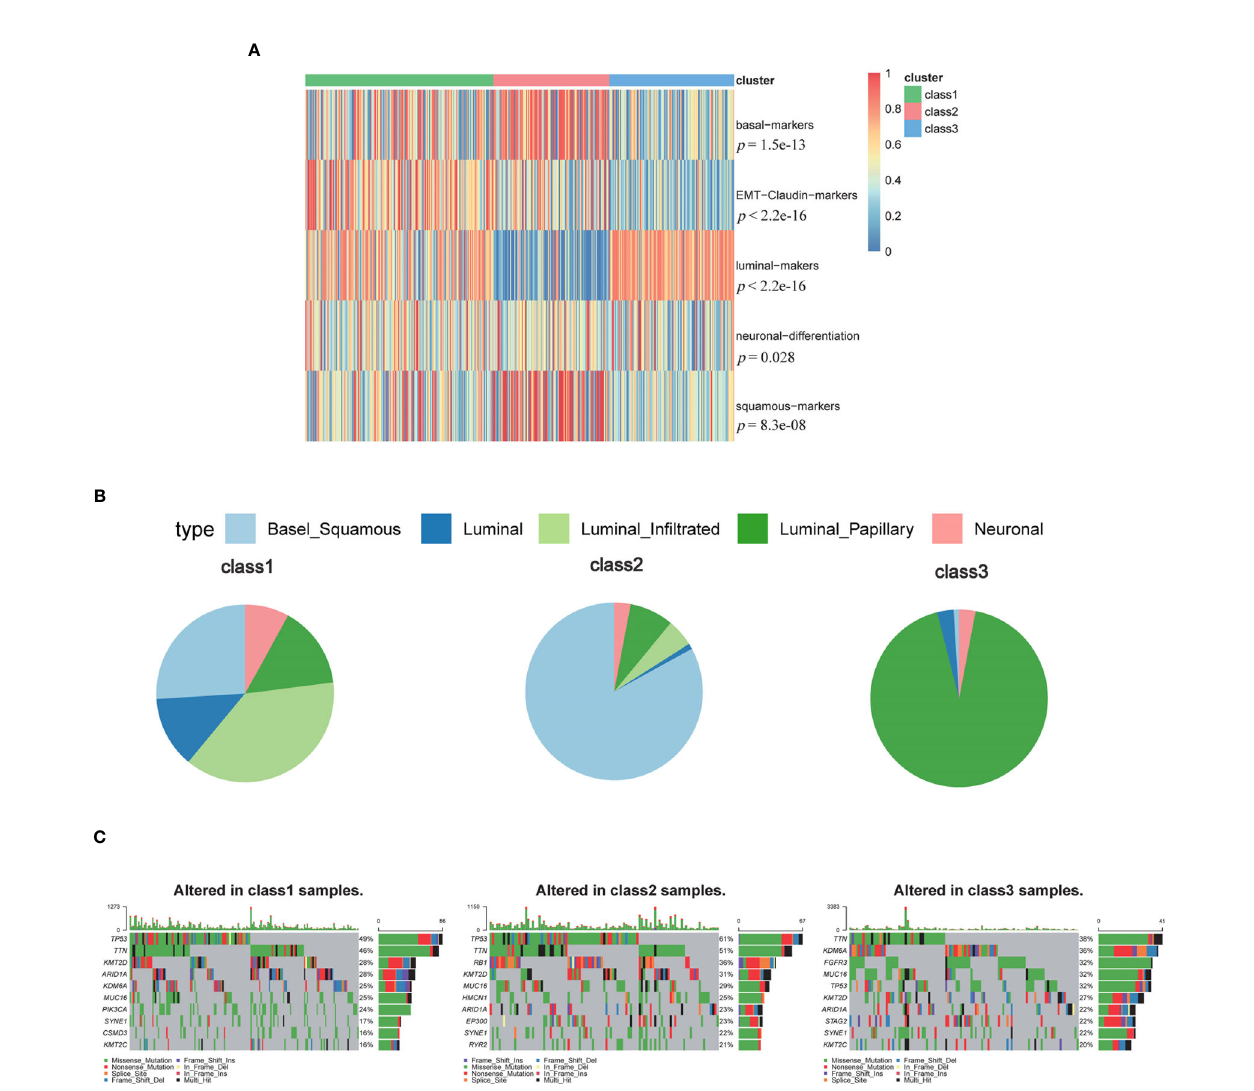
FIGURE 5 | The biomarkers of other subtypes and mutations among three subclasses. (A) The biomarkers of other published subtypes among three subclasses. (B) Percent of Robertson ’ s subtypes. (C) Top mutations in class 1, class 2 and class